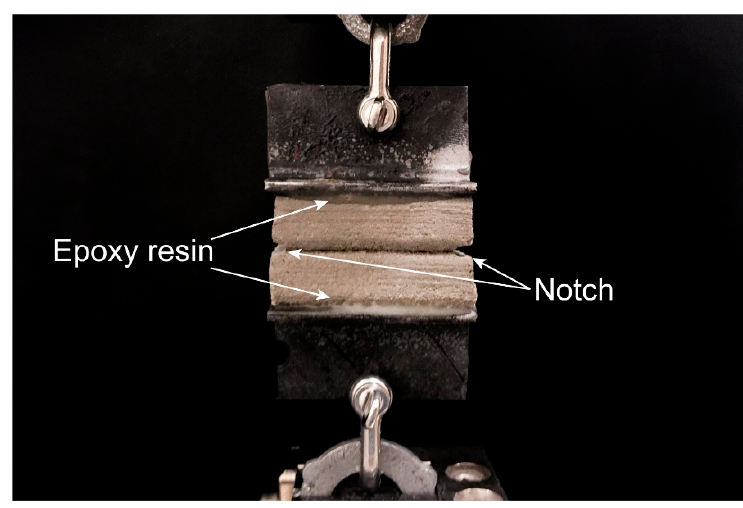
Figure 5. The inter-layer bond strength test of 3D-printed geopolymer mortar.